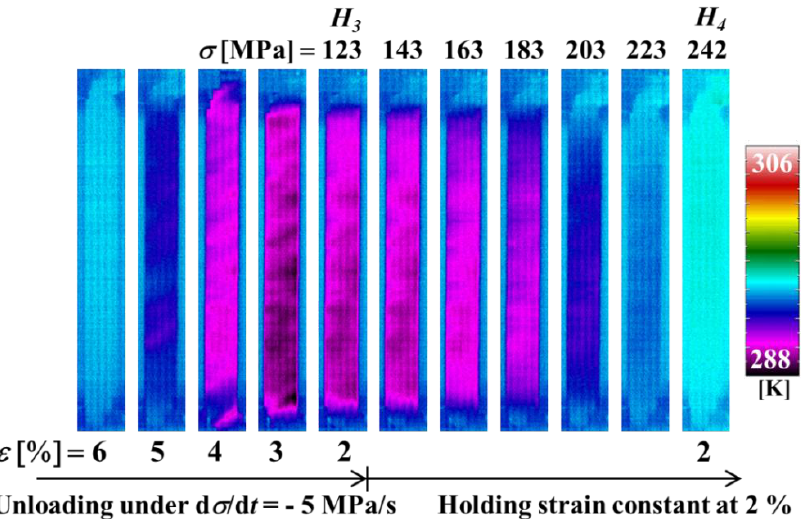
Figure 8. Thermograms of temperature distribution on the specimen surface at various strains ε during unloading under a stress rate of −5 MPa/s till a point H various stresses σ while holding the strain constant at 2% until point H